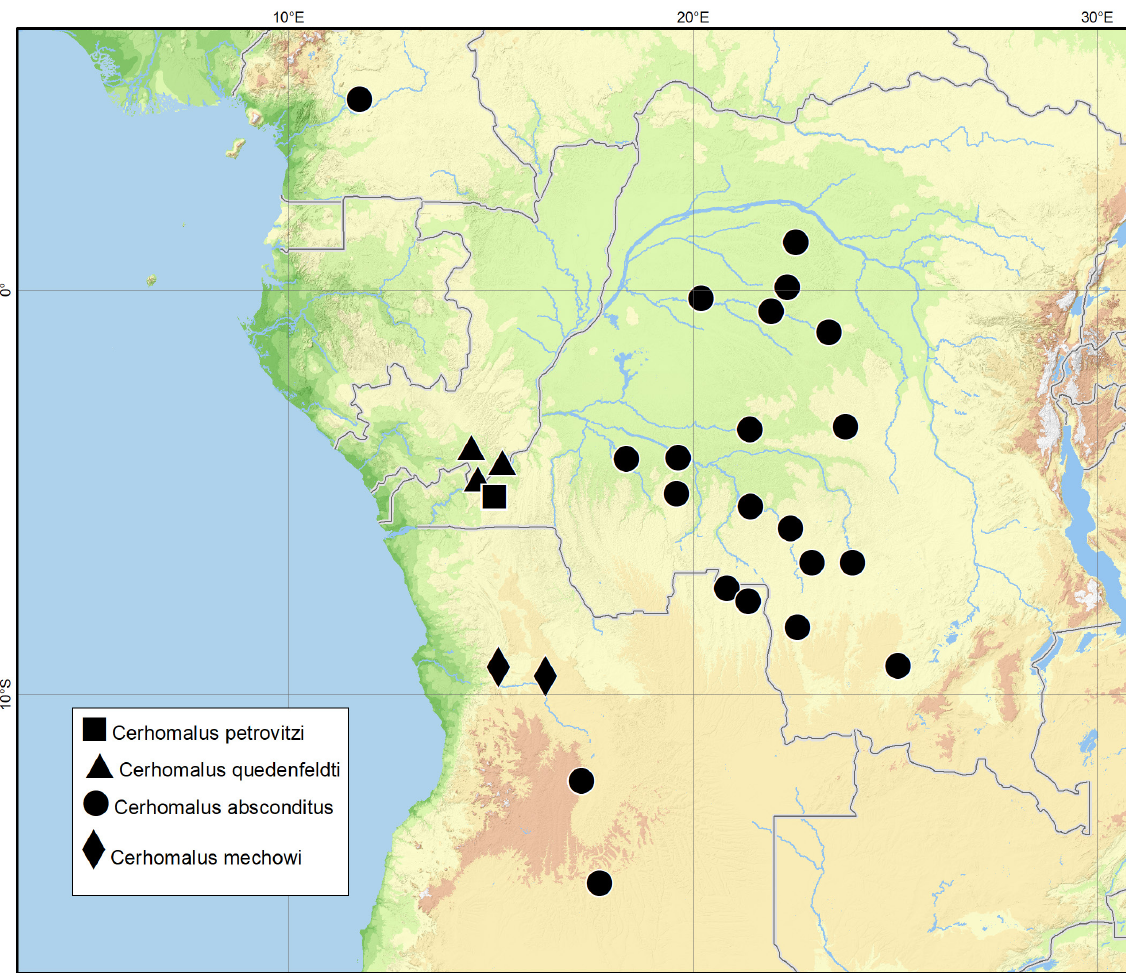
Fig. 6. Cerhomalus spp., distributional record